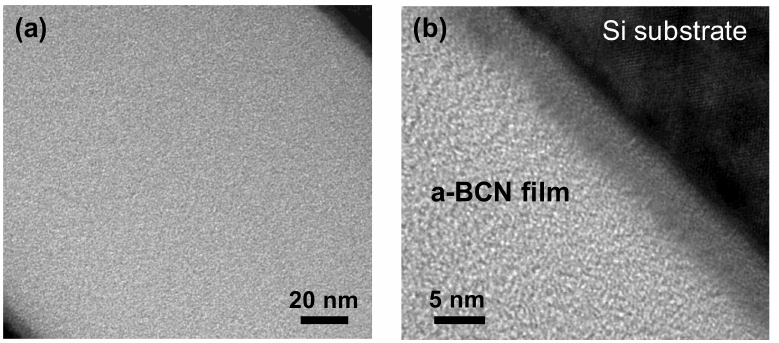
Figure 2. Cross-sectional TEM image of the a-BCN film: ( a ) Over view of the a-BCN cross section (low magnification); ( b ) Close up view of the a-BCN cross section (high